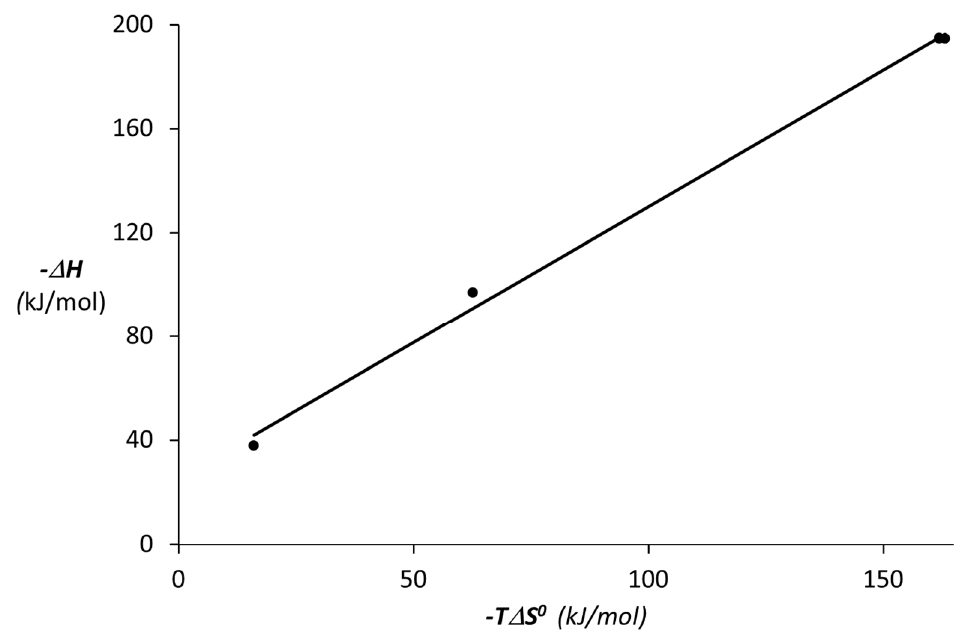
Figure 5. Enthalpy–entropy compensation plot. Plot of the − ∆ H versus − T ∆ S 0 for the binding of compounds 12 – 14 and 18 to Gal-3. The plot shows a linear relationship with a slope of 1.05 and a correlation coefficient of 0.997.